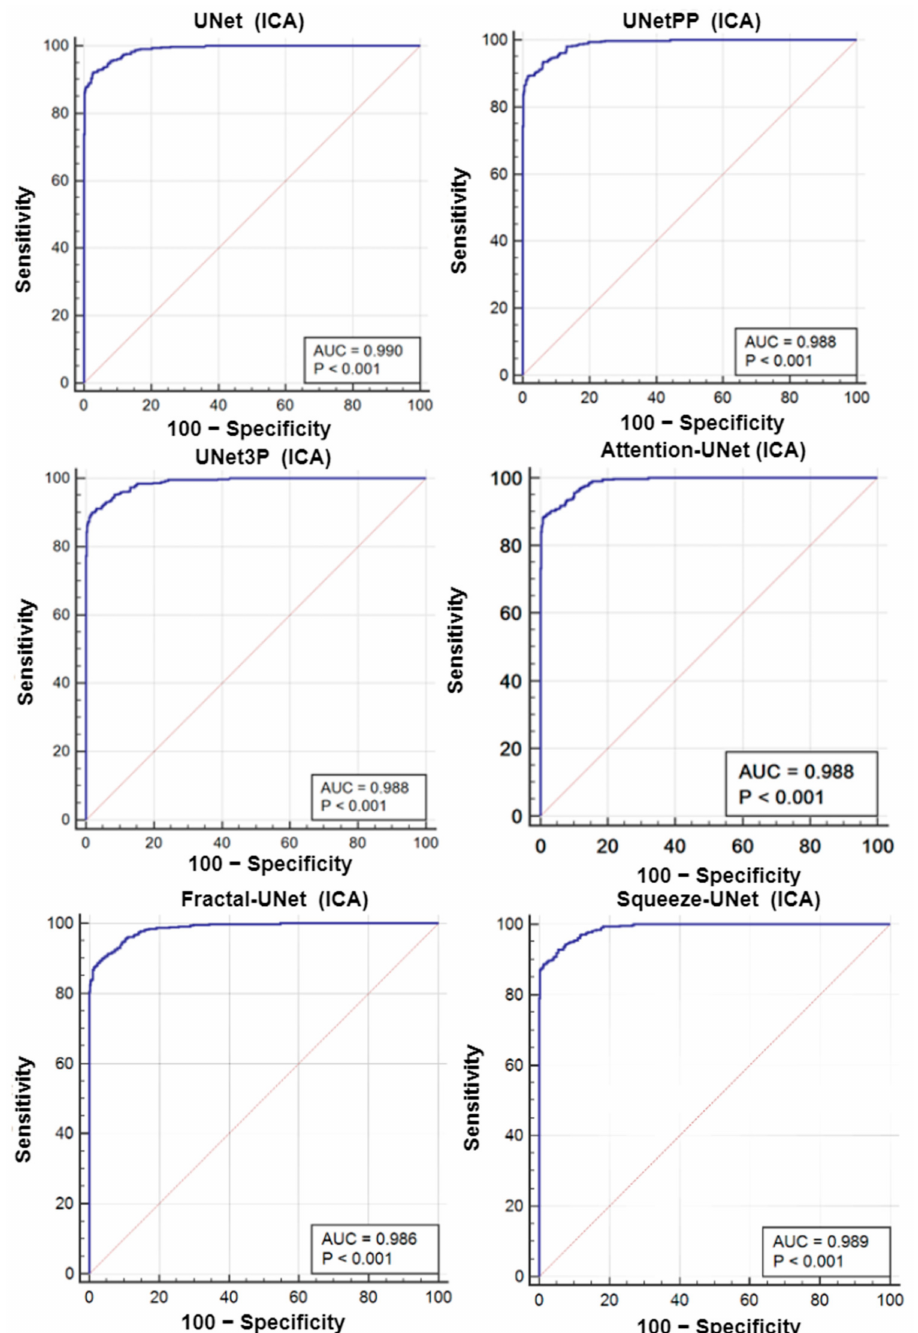
Figure 12. ROC curves for all 6 types of UNet model for ICA DB1